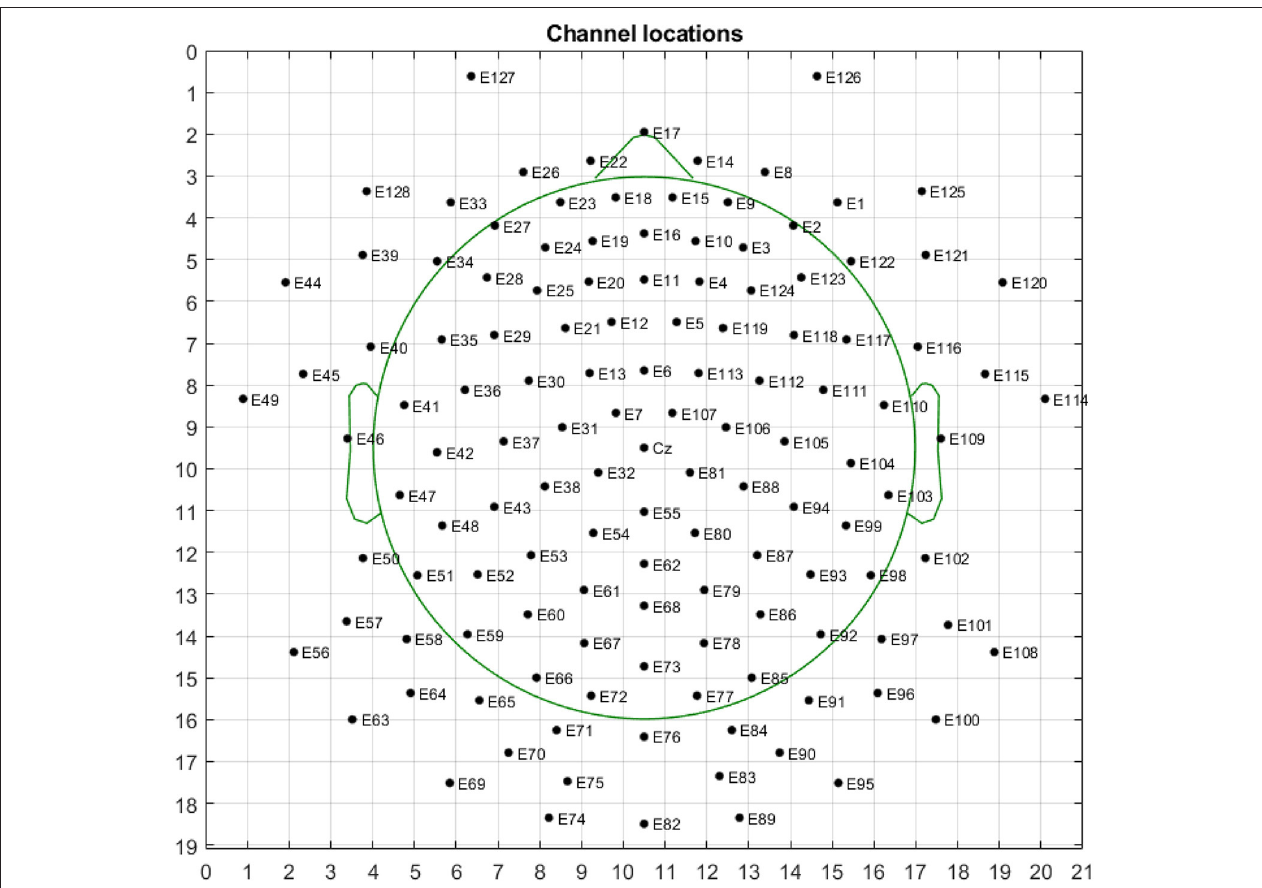
FIGURE 7 | Topological structure map of 128-electrode channels mapped to a two-dimensional picture. The circle represents the electrode, and the label inside is the serial number and name of the electrode.